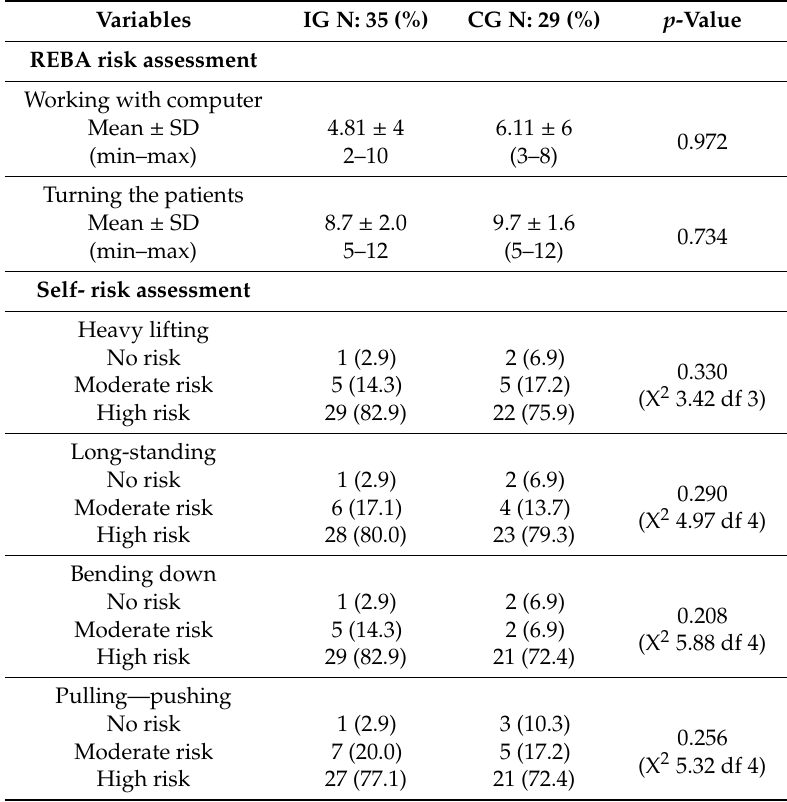
Table 3. Rapid Entire Body Assessment (REBA) risk assessment and self-risk assessment by nurses.